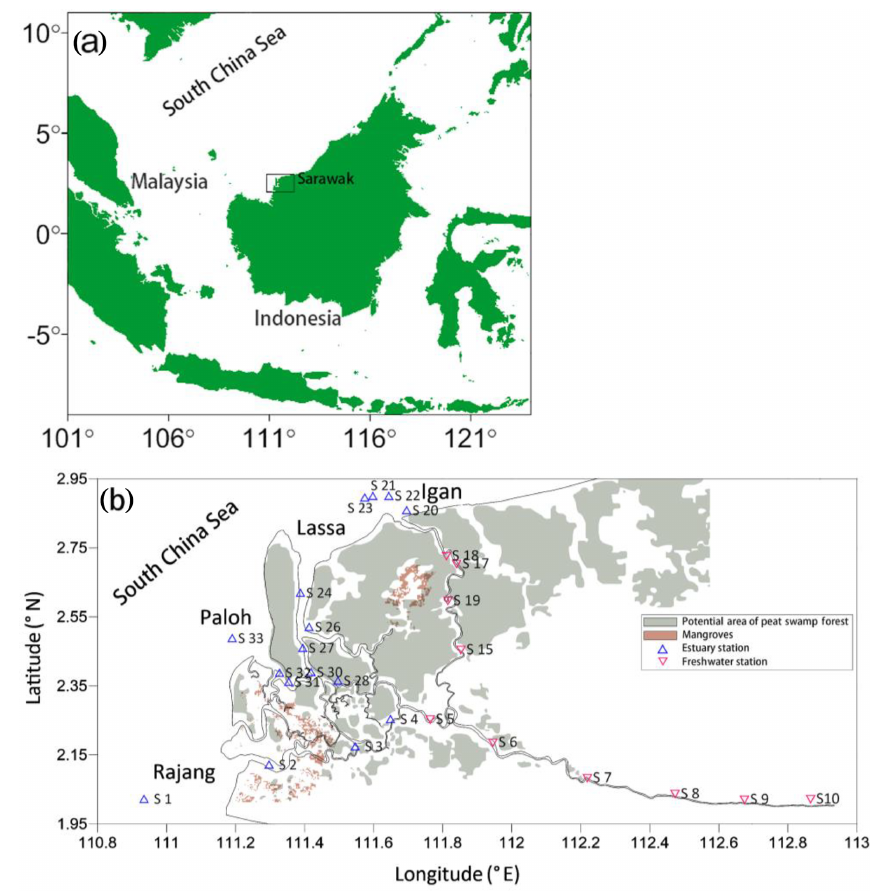
Figure 1. Study area and sampling stations. (a) Location of Sarawak, Malaysia, and (b) the Rajang with its estuary and river mouth shown. Samples upstream of S5 had 0 salinity and downstream of S5 had salinity > 0. Hence, from S5 to S10 was regarded as the freshwater section (red triangles), and downstream of S5 was regarded as the estuarine section (blue triangles). Note that the salinity of samples at S15, S17, S18, and S19 was also 0 during our